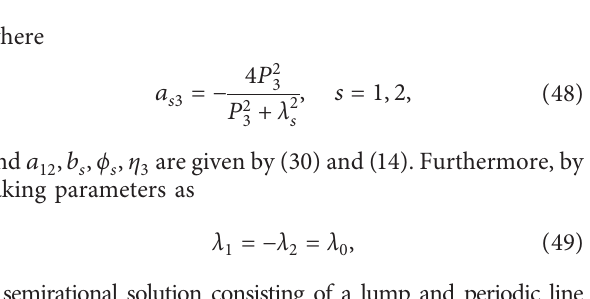
Figure 5: The interaction of two fundamental lumps at different values in time: (a) t �− 2. (b) t �− 1. (c) t � 0. (d) t � 1/2. (e) t � 1. (f) t � 2.